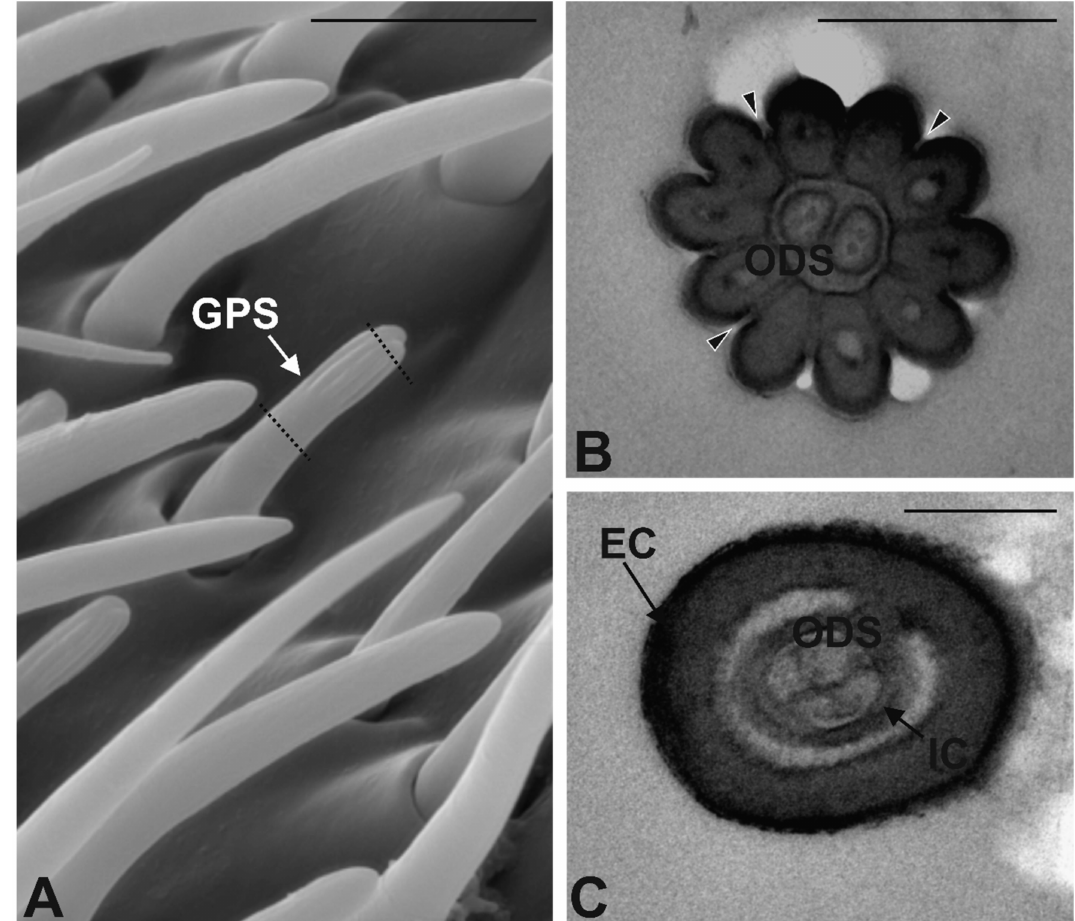
Figure 7. Grooved Peg Sensilla (GPS). ( A ) SEM micrograph showing an GPS sensillum characterized by the presence of finger-like projections in the apical part. Dotted lines correspond to the TEM section planes. ( B , C ) TEM cross section taken at the apical and proximal region, respectively. In ( B ) the sensillum shows a cuticle organized in thick cuticular elements corresponding to the external finger-like projections. At the level of the grooves several pores can be observed crossing the whole cuticle. The internal lumen is occupied by two outer dendric segments (ODS). In C the section is taken at a lower level and shows a typical double-walled organization, with the external cuticular wall (EC) and the internal cuticular wall (IC) enclosing three outer dendritic segments. Bar scale: ( A ) 5 µ m; ( B , C ) 0.5 µ